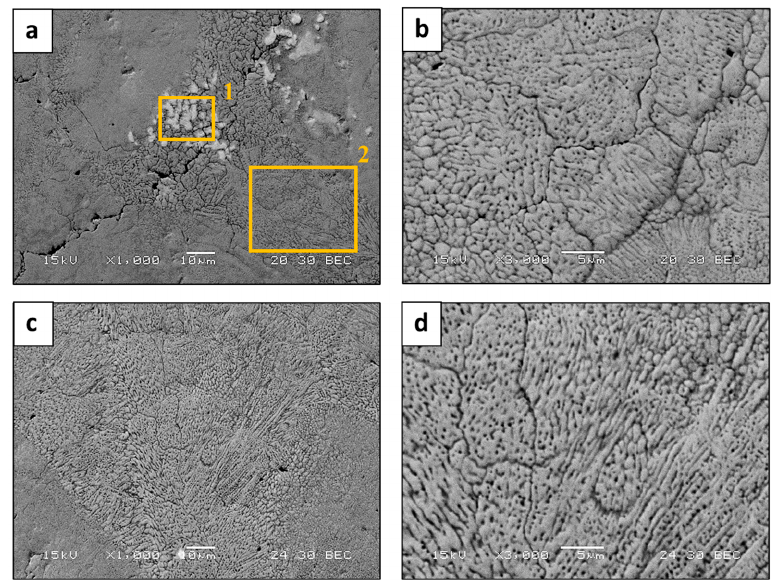
Figure 4. Microstructure of HEA WTaMoNbV produced by LPBF in terms of SEM backscattered electron mode: ( a , b ) XY plane, ( c , d ) XZ plane. Table 6. Local chemical compositions (at. %) by EDS analysis, related to Figure 4a.